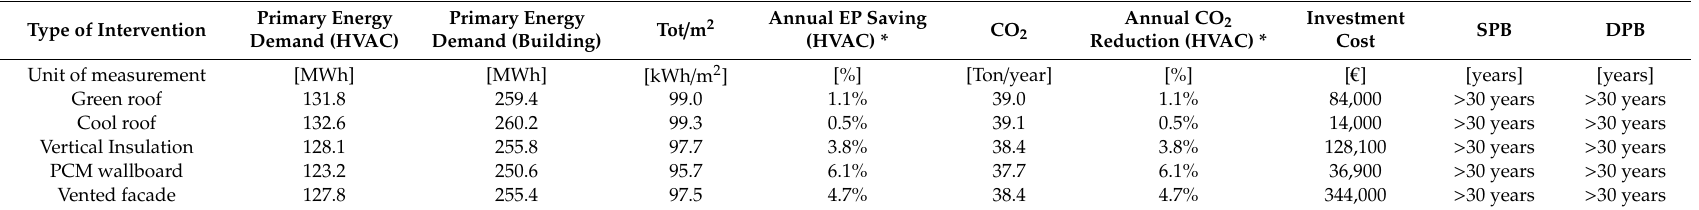
Table 7. Results of the energy and economic analyses of the retrofit measures applied to the case study.